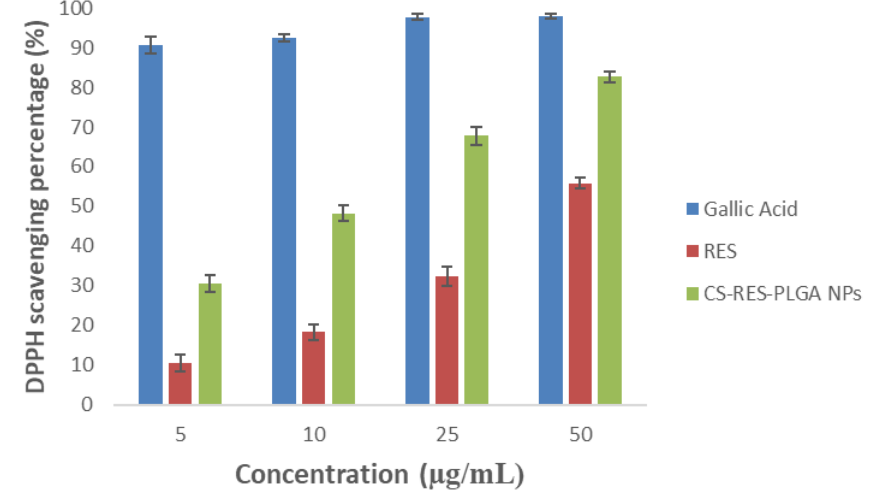
Figure 8. DPPH scavenging activity of free resveratrol, CS-RES-PLGA NPs and gallic acid at different concentrations. ( p < 0.05; RES vs. CS-RES-PLGA NPs).